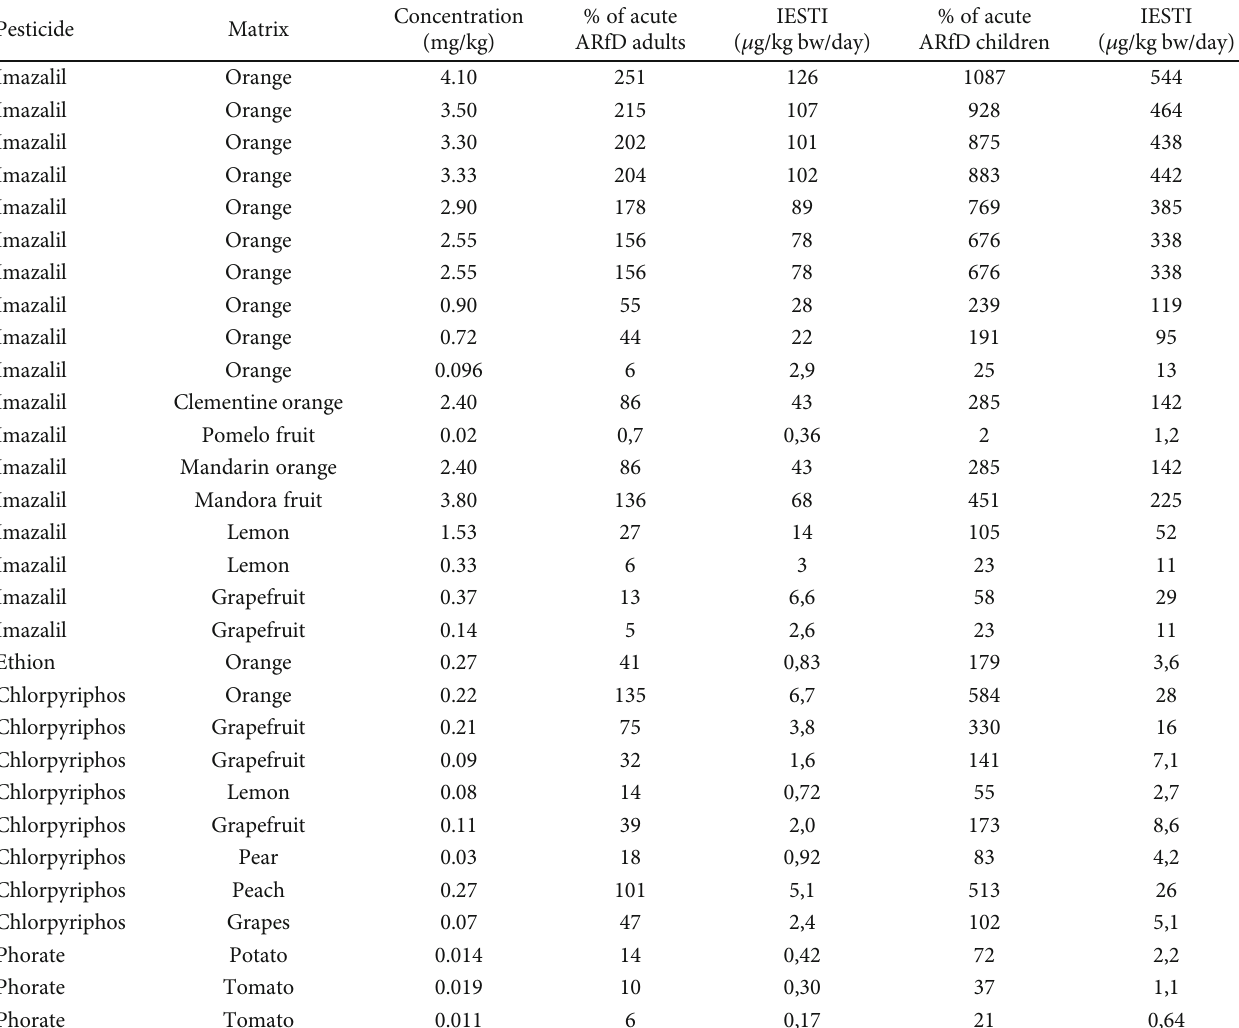
Table 2: Pesticide residue concentration and assessment of acute exposure of adults and children to detected pesticides. Pesticide Matrix